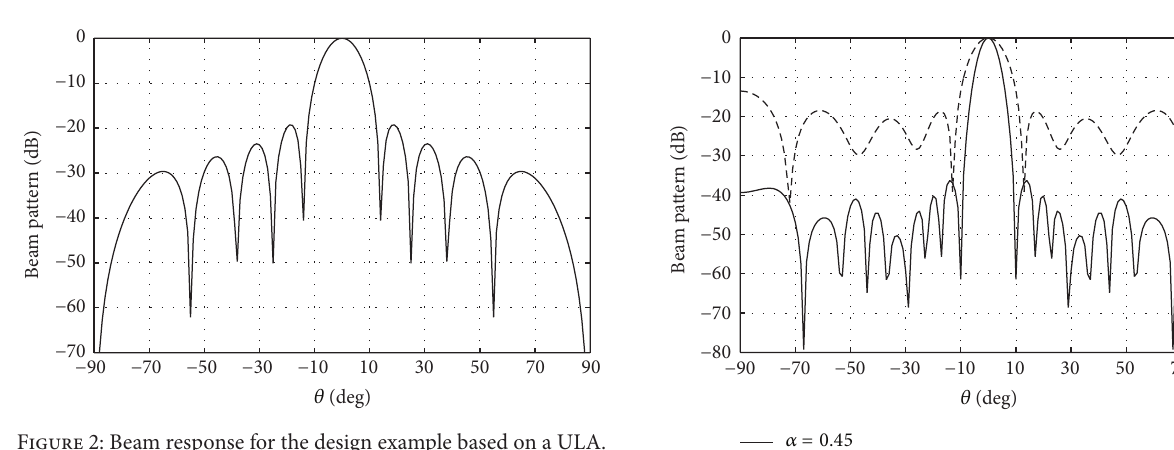
Figure 2: Beam response for the design example based on a ULA. Table 1: Locations found from solving (23) with a value of 𝛼 = 0.94 . Figure 3: Beam response for the locations found by solving (23).